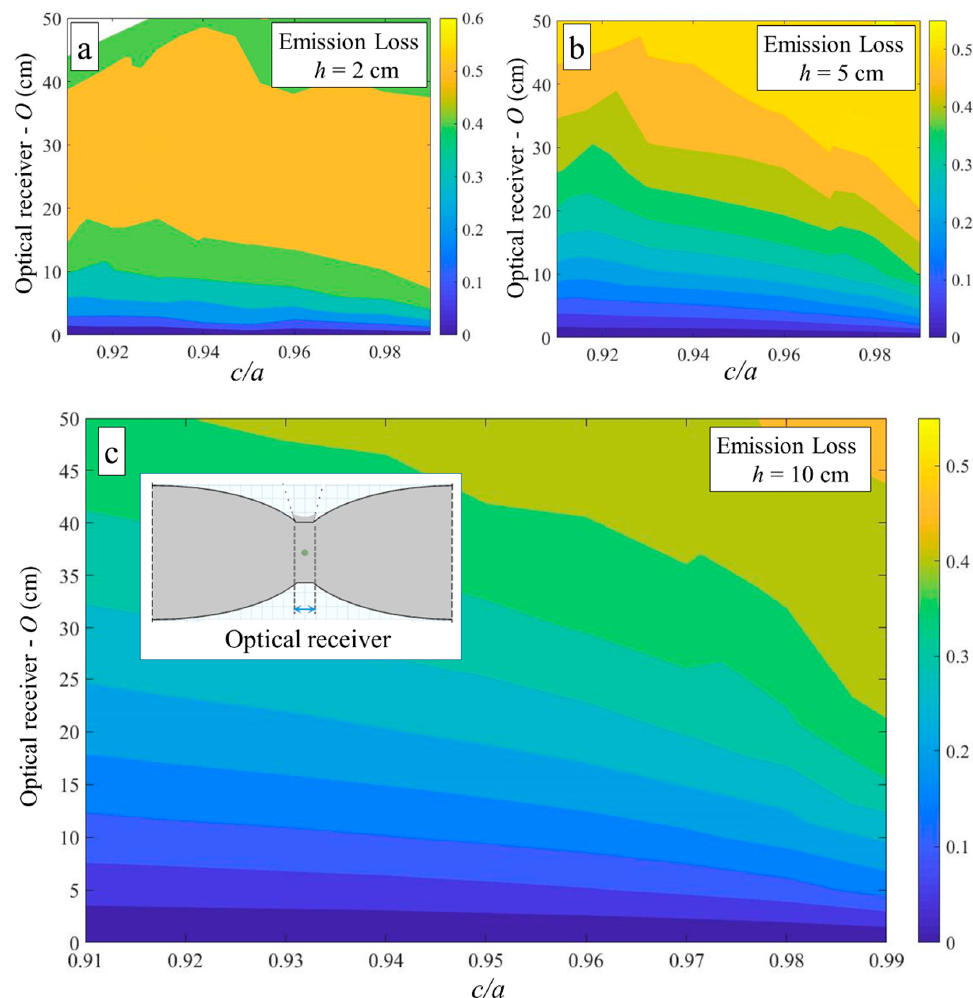
Figure 9. Emission losses as a function of c / a and the width of the optical receiver port ( O ) for ( a ) h = 2 cm, ( b ) h = 5 cm and ( c ) h = 10 cm.